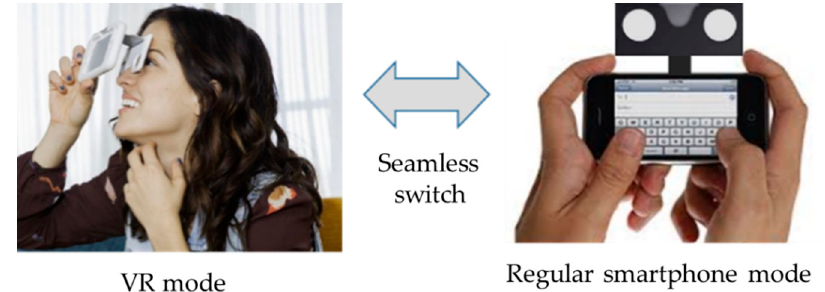
Figure 2. Main features of “EasyVR”: (1) quick put-on, (2) no inconvenient mounting on the head, (3) seamless switch between regular smartphone and VR modes, (4) touch screen based interaction possible (and no additional interaction devices—self-contained).